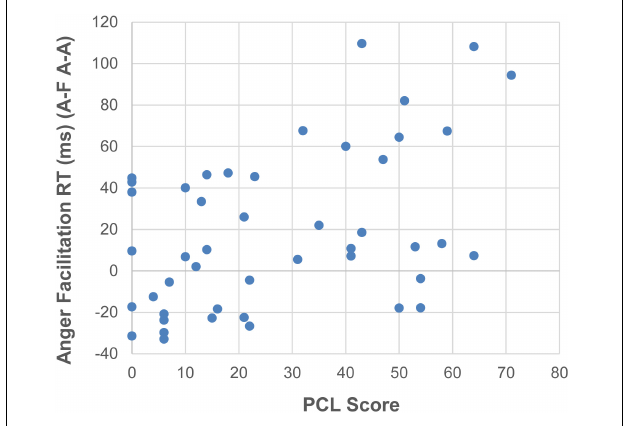
FIGURE 3 | Positive correlation between facilitation RTs on angry target faces (A–F – A–A) and PTSD symptoms on the